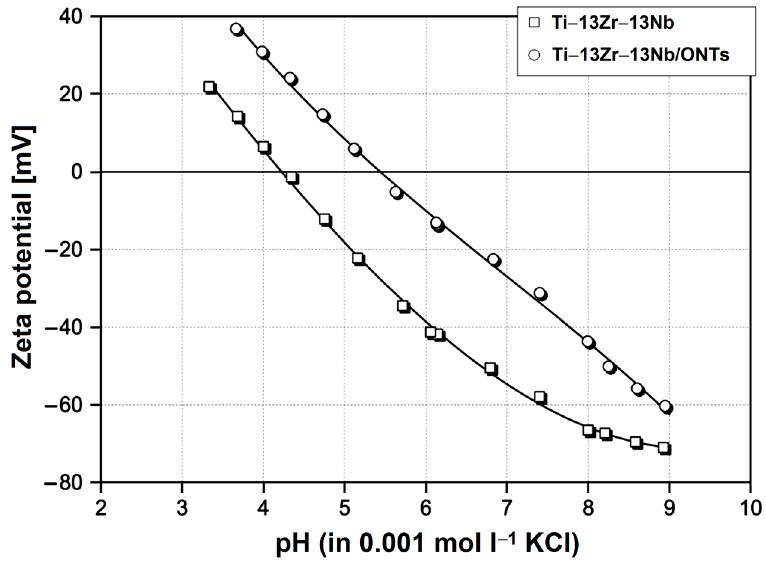
Figure 8. Dependence of electrolyte pH on zeta potential for the Ti–13Zr–13Nb alloy without and with the ONTs layer in 0.001 mol l − 1 KCl.